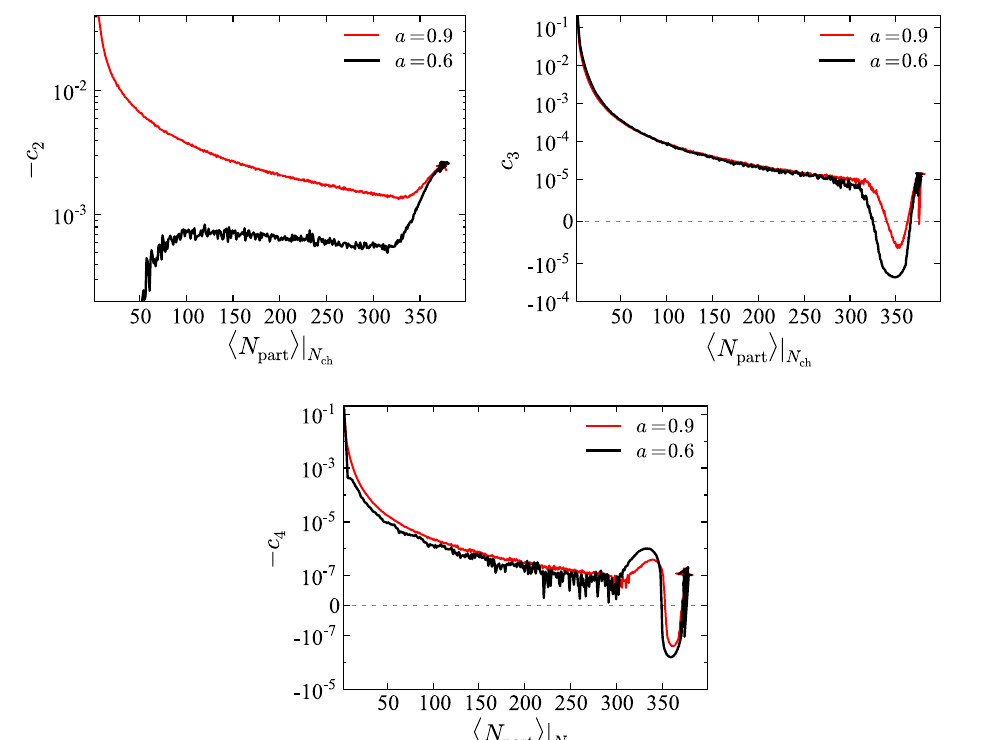
Fig. 5 Same as Fig. 1 but for different values of parameter a of Eq. (15). Instead of a = 0 . 75 we use a = 0 . 6 black lines , and a = 0 . 9 red